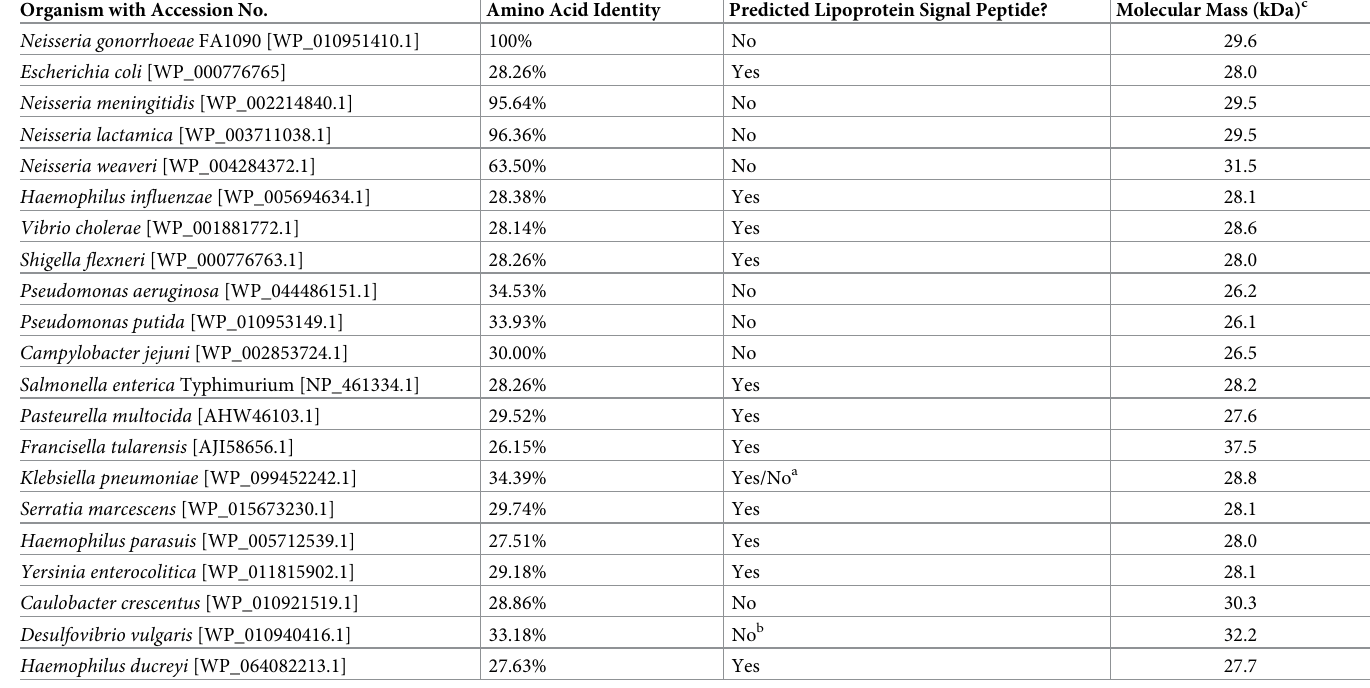
Table 1. Amino acid identity of MlaA